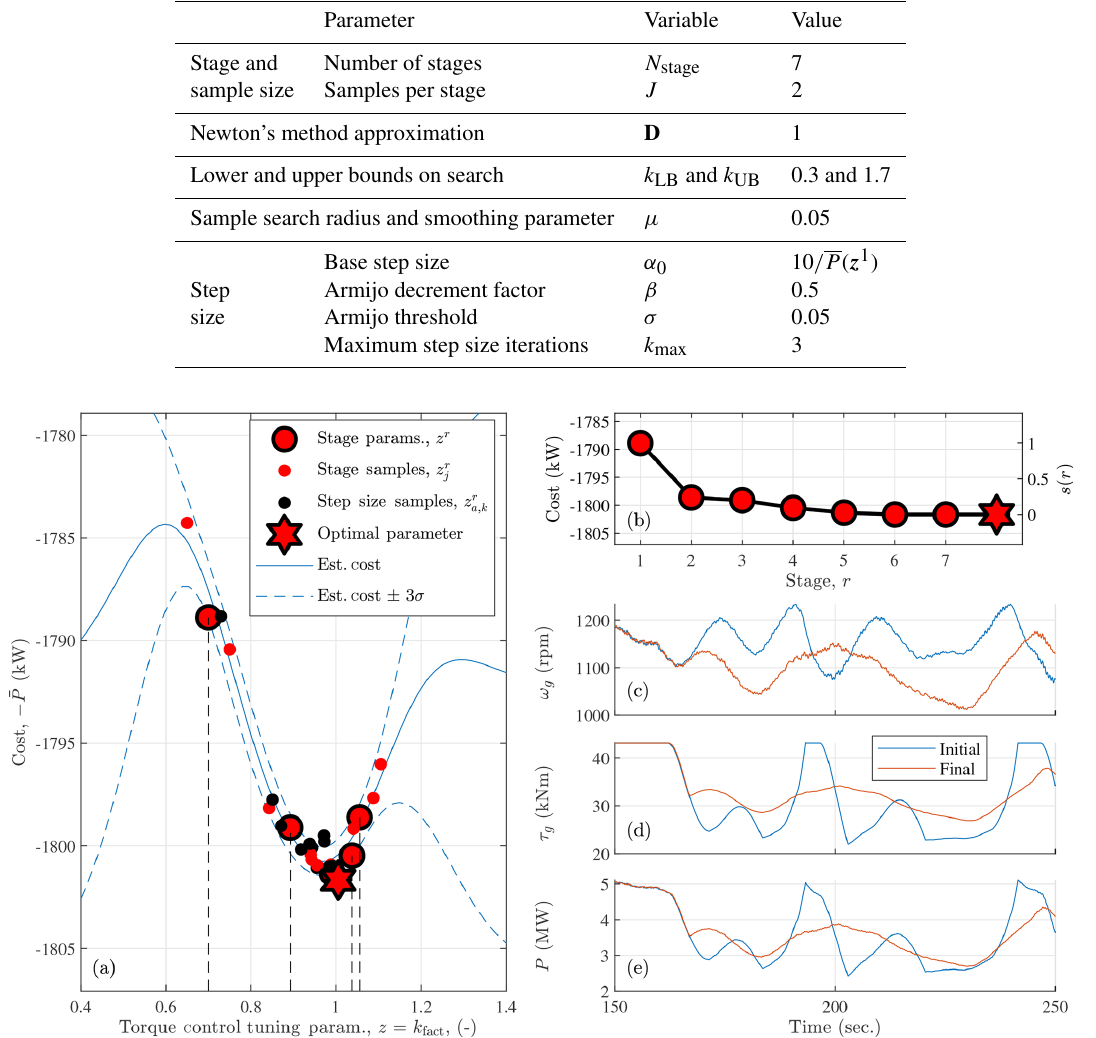
Table 1. Design choices for 1-D parameter search to optimize the torque gain in below-rated control.